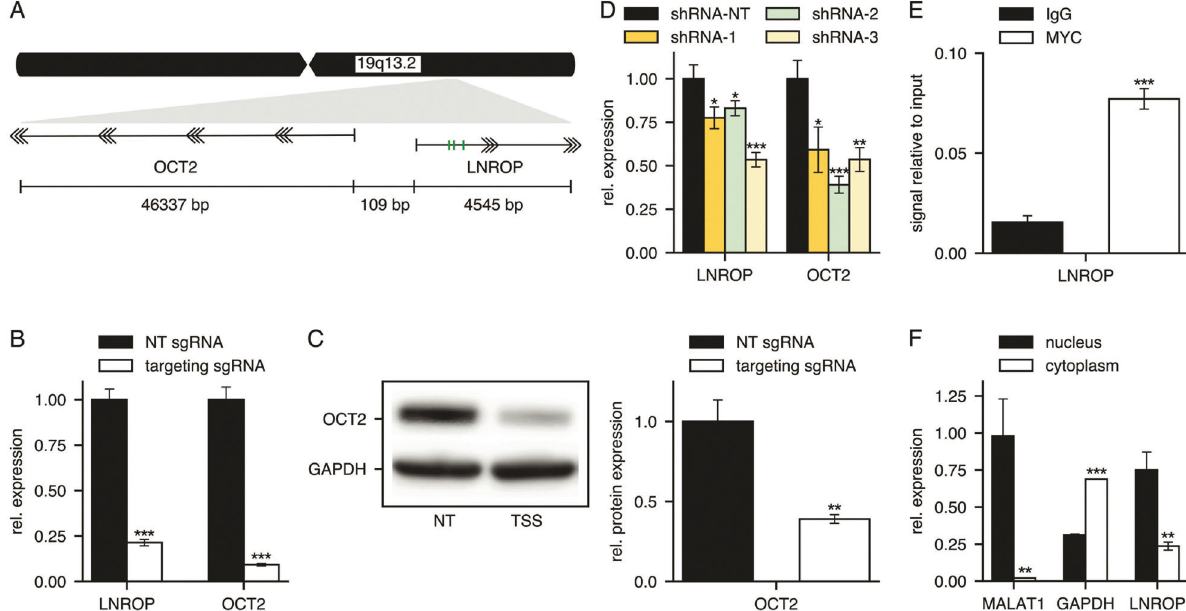
Fig. 1 Functional characterization of LNROP as a regulator of OCT2 expression in RAMOS cells. A Schematic representation of OCT2 and LNROP loci based on data retrieved from Genome Browser (Gencode v39). Green bars indicate the three canonical (5 ’ -CACGTG-3 ’ ) MYC E-boxes present in the sequence of LNROP and located 1082, 1096 and 1334 base pairs away from the TSS. B RT-qPCR analysis for the expression of LNROP and OCT2 in RAMOS cells after CRISPRi using sgRNAs directed against the TSS of LNROP compared to non-targeting (NT) guides. Data are mean ± SD of three replicates. C Western blot analysis of OCT2 expression in RAMOS cells after CRISPRi-mediated downregulation of LNROP using sgRNAs directed against the TSS of LNROP and a non-targeting guide (NT) as control. Western blot image ( Left ) was analyzed using Fiji software to quantify the expression of OCT2 relative to the loading control GAPDH ( Right ). Data are mean ± SD of three replicates. D RT-qPCR analysis for the expression of LNROP and OCT2 in RAMOS cells after RNA interference using small-hairpin RNA constructs targeting 3 different sites of the LNROP sequence. Data are mean ± SD of three replicates. E ChIP-qPCR analysis of MYC binding to the LNROP promoter in RAMOS cells. Normal Rabbit IgG was used as control. Data are mean ± SD of three replicates. F RT-qPCR analysis for the cytoplasmic/nuclear distribution of LNROP transcripts after cellular fractionation. MALAT1 and GAPDH served as nuclear and cytoplasmic markers, respectively. Data are mean ± SD of three replicates. * P < 0.05; ** P < 0.01; *** P < 0.001, unpaired t